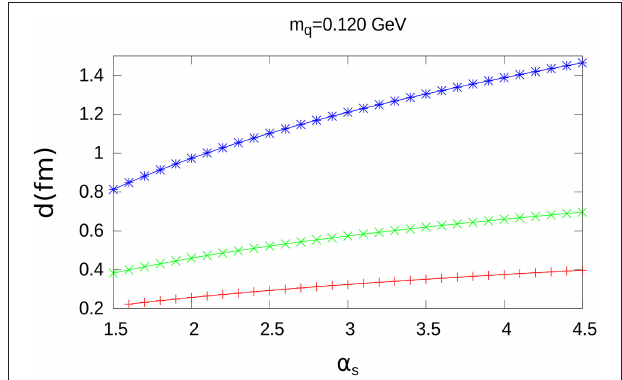
FIGURE 7 | Value of d as a function of α s . The same conventions as in the previous figures are used.